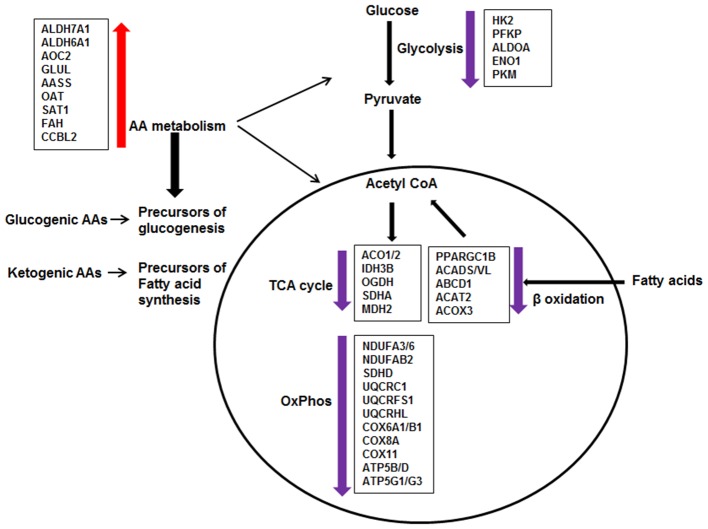
Effect of DEX on metabolic pathways in sarcoid AMs. The pathway analysis of metabolic DE genes showed that the major pathways affected in DEX-treated sarcoid AMs as compared to untreated sarcoid AMS were: Glycolysis, Citric acid cycle (TCA), Oxidative phosphorylation (OxPhos), β-oxidation of fatty acids and Amino acid (AA) metabolism. DEX-treatment resulted in the downregulation of genes involved in glycolysis, TCA cycle, Oxphos and β-oxidation of fatty acids. Alteration in these pathways suggests that glucose metabolism is decreased; glucose is not being utilized completely to generate energy producing molecules ATP and NADH. Reduced β-oxidation of fatty acids suggests that fatty acids are not being transported and degraded optimally in mitochondria to generate energy. Suboptimal fatty acid oxidation may result in the accumulation of long chain fatty acids and metabolites. The upregulation of genes involved in AA metabolism shows that DEX-treated sarcoid AMs may switch to AA catabolism as a source of energy. AAs catabolism results in the conversion of AAs either to pyruvate or intermediates of TCA cycle for energy production or generation of precursors of glucogenesis and fatty acid synthesis.